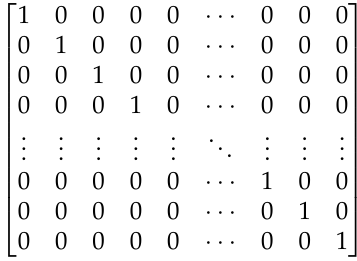
Figure 4. Example of one